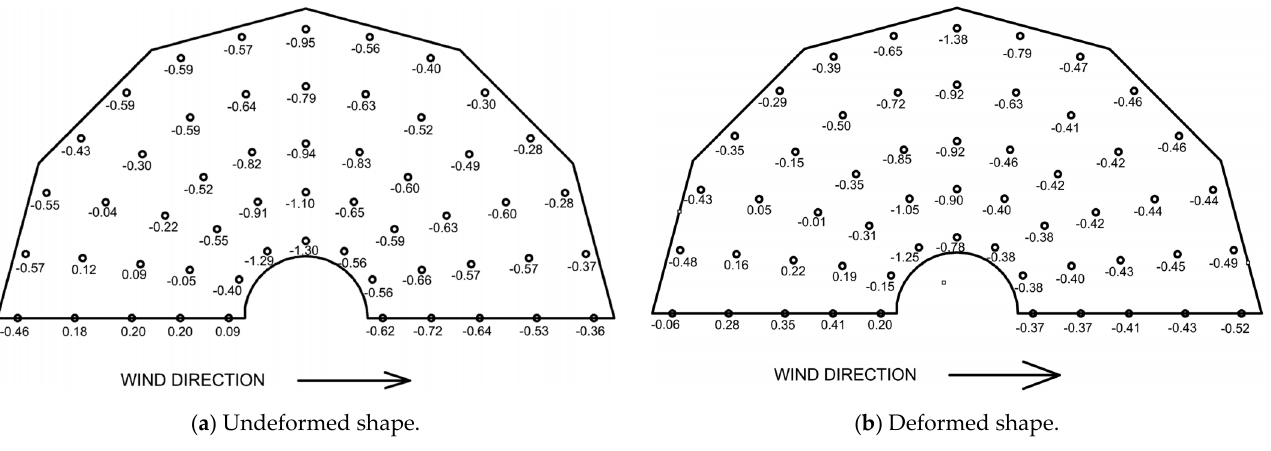
Figure 11. Coefficients of pressure on the surface [30].